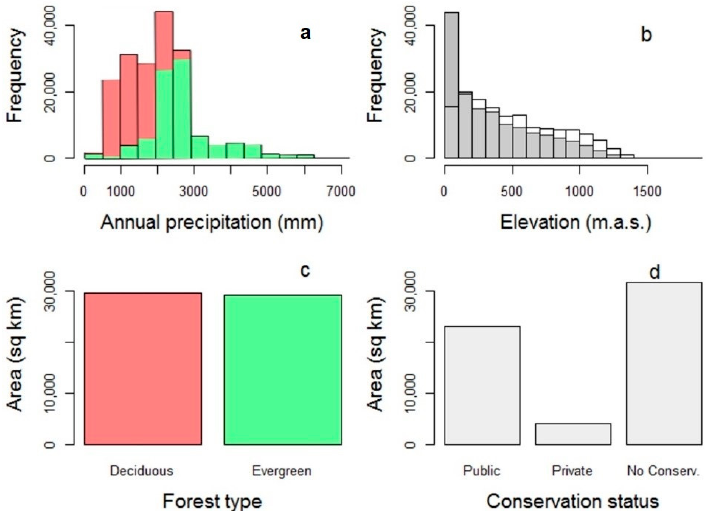
Figure 5. Elevation and bioclimatic distribution and vegetation cover of potential IFWs in the regional mapping area. Annual precipitation related to forest type (( a ), stacked graph), watershed discharge elevation (grey) and mean elevation (superimposed, white) ( b ), forest type ( c ), and conservation status ( d ).